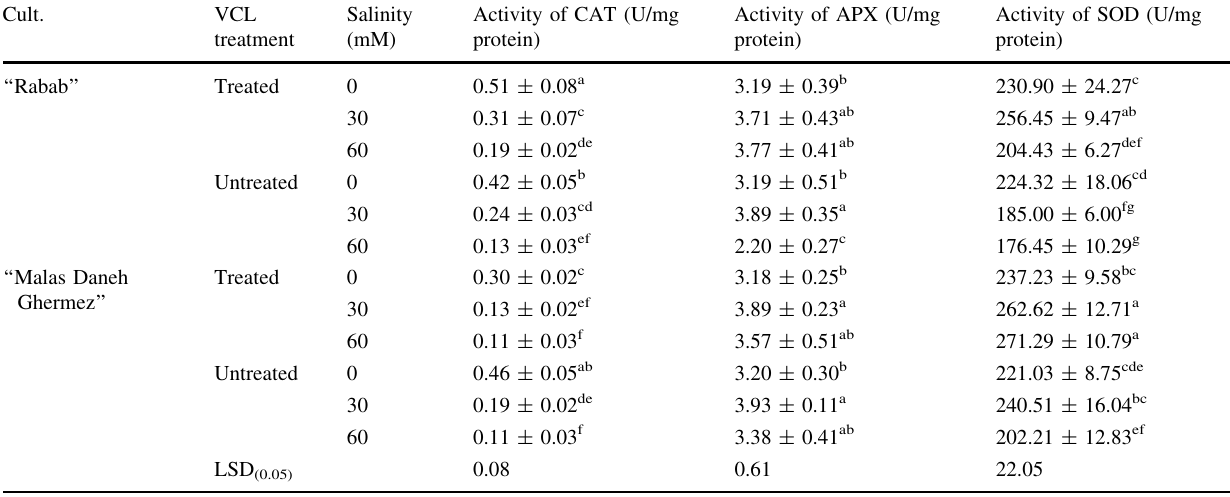
Table 6 Effects of VCL treatments on the activity of CAT, APX, and SOD of pomegranate seedlings under NaCl-induced salt stress Cult.